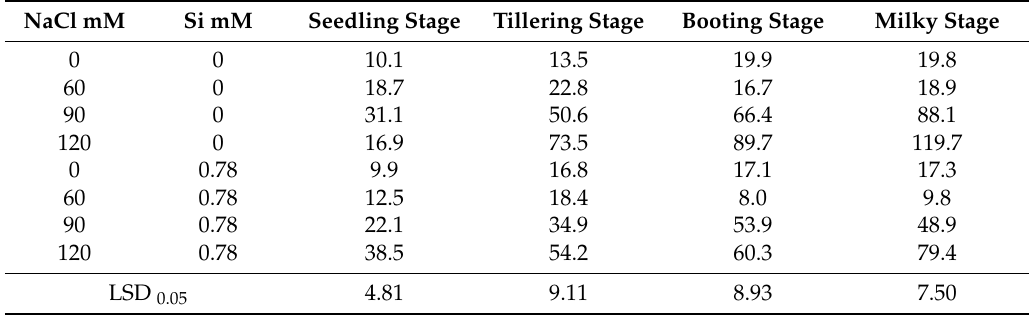
Table 3. Effect of NaCl on the H 2 O 2 contents ( µ mol g − 1 fresh weight) of wheat leaves at different growth stages in the presence and absence of silicon. NaCl mM Si mM Seedling Stage Tillering Stage Booting Stage Milky